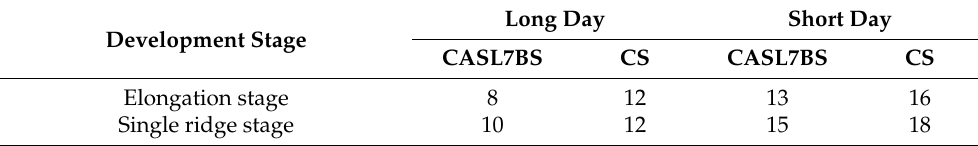
Figure 6. Young spikes in the different developmental stages of CASL7BS and CS. ( a ): No vernalization and grown under LD (18 – 25 °C, 16 h light/8 h dark); ( b ): vernalization under LD (4 – 7 °C, 16 h light/8 h dark) for about 20 d, but grown under SD (18 – 25 °C, 8 h light/16 h dark). A. Elongation stage; B. single ridge stage; C. two ridge stage; D. glume protuberances stage; E. floret differentiation stage, F. pistil and stamen differentiation stage; G. connective formation stage; H. Tetrad formation stage. Scale bars from A–D were equal to 200 µ m, those from E–F equal to 1 mm. Table 1. Young spike development process of CASL7BS and Chinese Spring